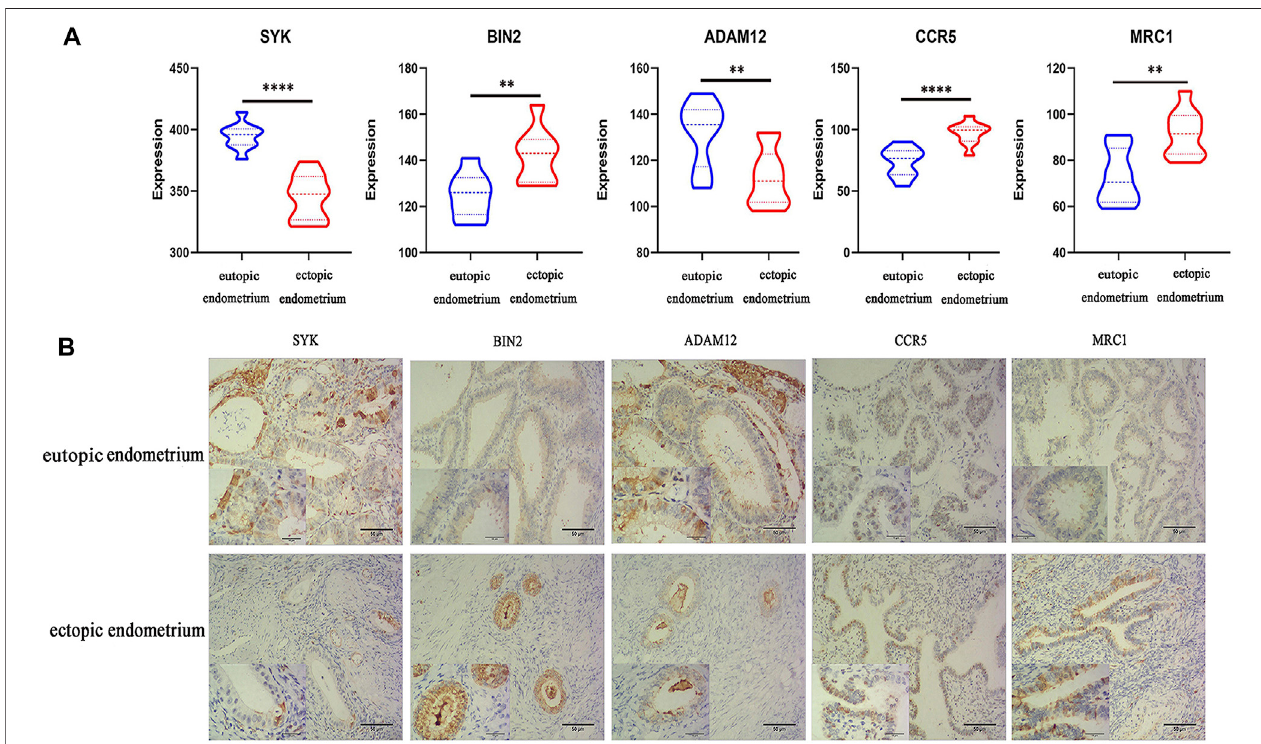
FIGURE6| ResultsofqRT-PCRandIHCanalysis. (A) Relativeexpressionsof fi vekeygenesintheeutopicendometriumandectopicendometrium,asdetermined by qRT-PCR analysis. (* p ＜ 0.05, ** p ＜ 0.01, *** p ＜ 0.005, **** p ＜ 0.001). (B) Relative protein expressions of fi ve key genes in the eutopic endometrium and ectopic endometrium, as determined by IHC